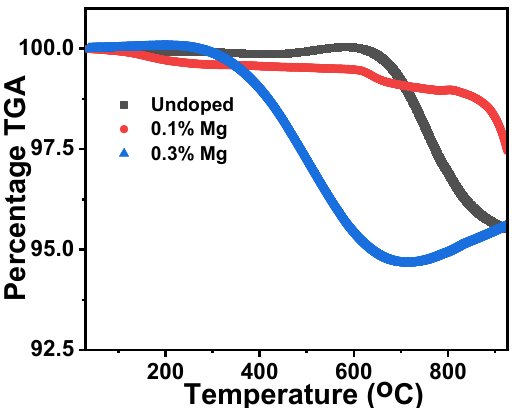
Figure 6. Thermal gravimetric analysis plots of undoped samples and some percentage composi ‐ tions of Mg ‐ doped lithium aluminium borate